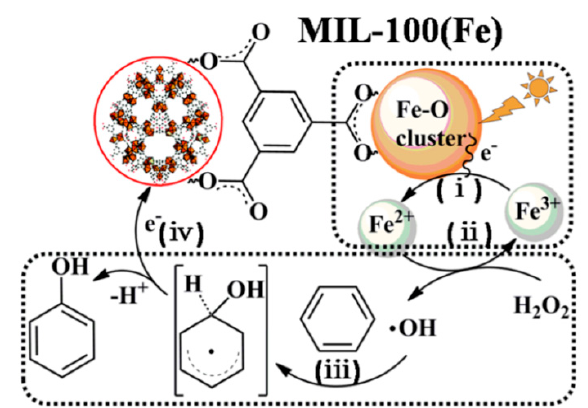
Figure 14. Photo-Fenton type mechanism for the hydroxylation of benzene catalyze by MIL-100(Fe). Adapted with permission from Reference [54], Copyright (2015) American Chemical Society.